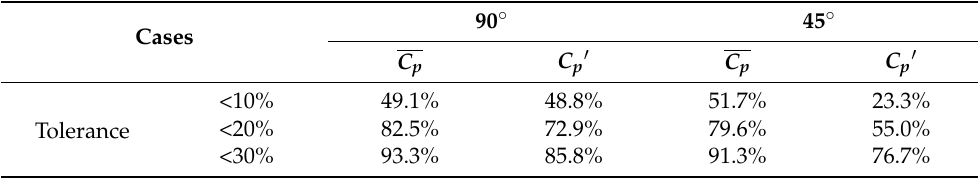
Figure 14. Correlation graphs of ( a , b ) the time-average surface pressure coefficient and ( c , d ) the fluctuation results of surface pressure coefficient on the whole building. Table 1. Comparison of pressure coefficient between the experimental and numerical data.